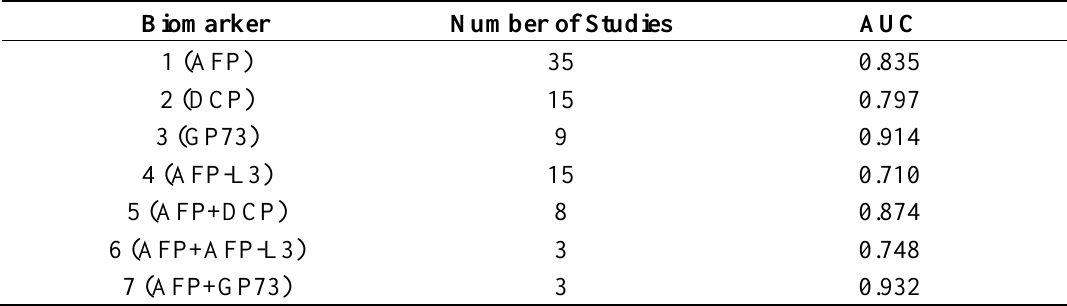
Table 3. The area under the curve (AUC) for each marker in the meta-analysis. Biomarker